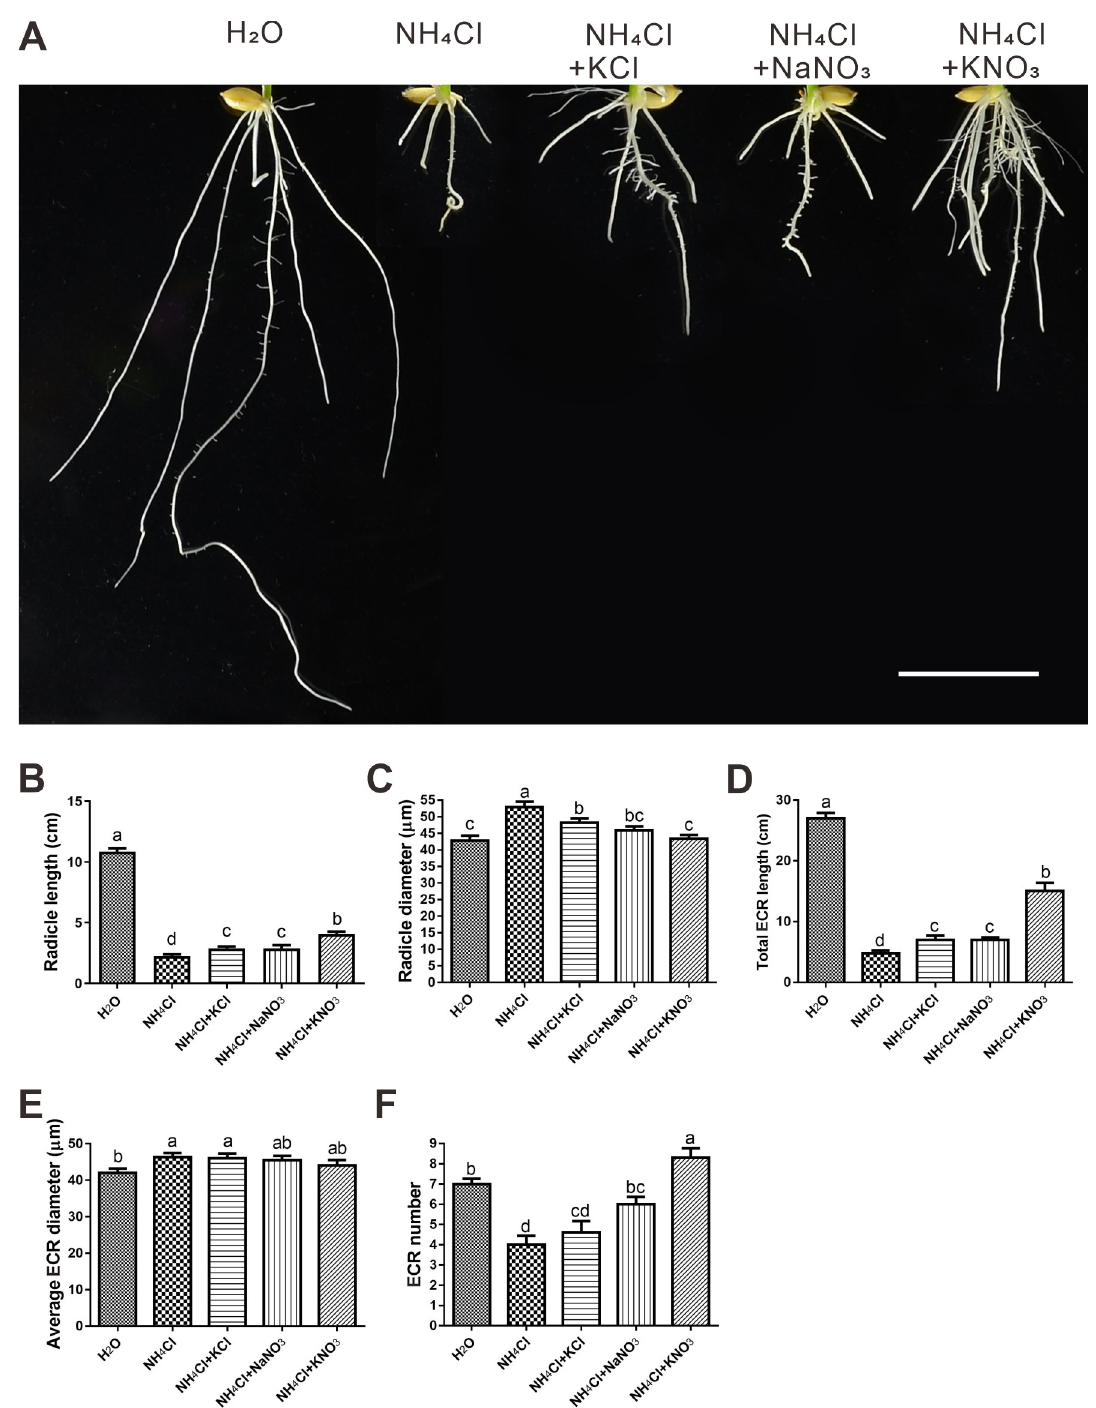
Fig 2. Root architecture. (A) Photograph of roots grown for 7 days. Scale bar = 2 cm. (B-F) Measured parameters. ECR = embryonic crown root. Data are mean ± SD, n = 10; t-tests were used to identify significant differences, and different letters represent significant differences among different treatments (p <